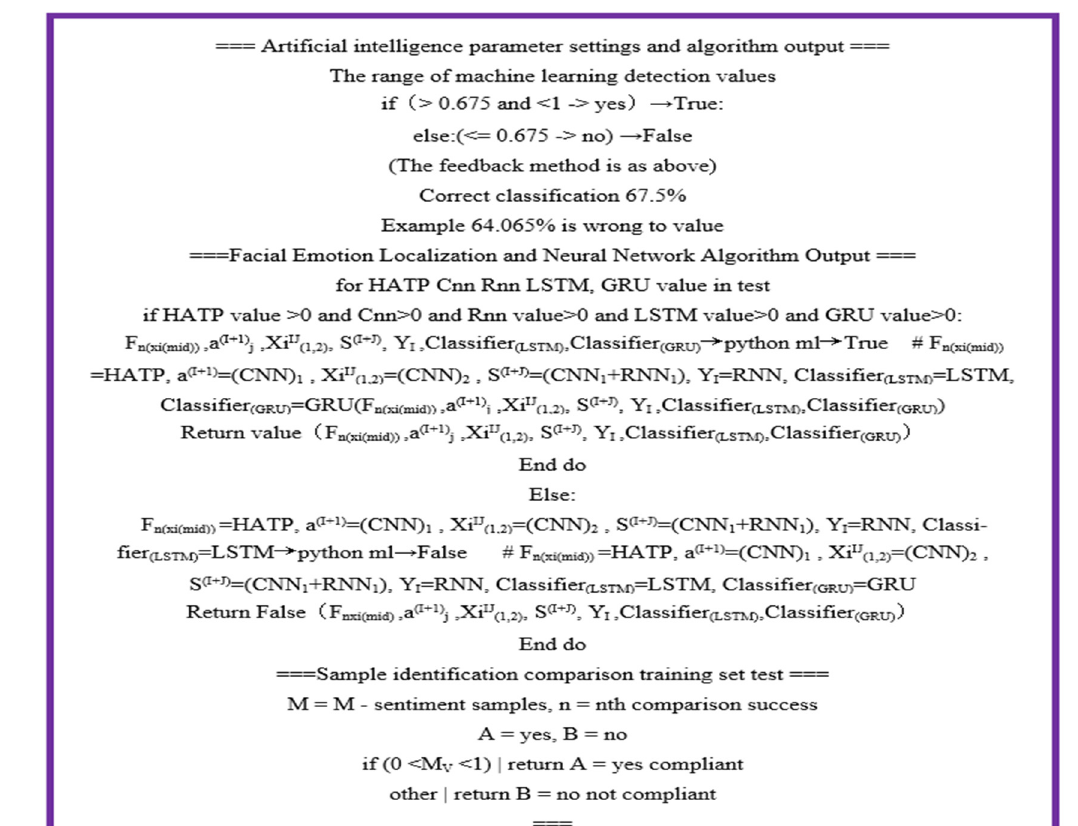
Figure 21. Machine learning algorithm output.